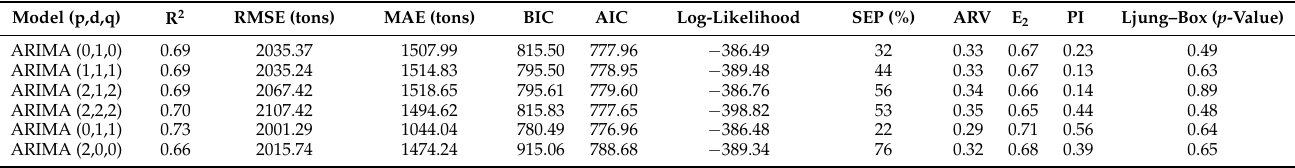
R 2 means coefficient of determination, RMSE means square root of the mean square error, MAE means mean absolute error, BIC means Bayesian information criterion, AIC means Akaike information criterion, SEP means percentage standard error of prediction, ARV means average relative variance, E 2 means efficiency Coefficient, PI means persistent index.